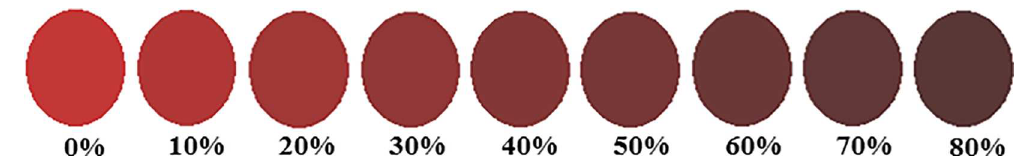
Fig 4. Percent methemoglobin color chart. Predicted RCV generatedfrom the starling, duck, and vole’s standardcurve equationswere averaged and used to generate custom color cards in MS Paint. Blue and green color values were estimated to be 40, which was based on the averageblue and green color values in these